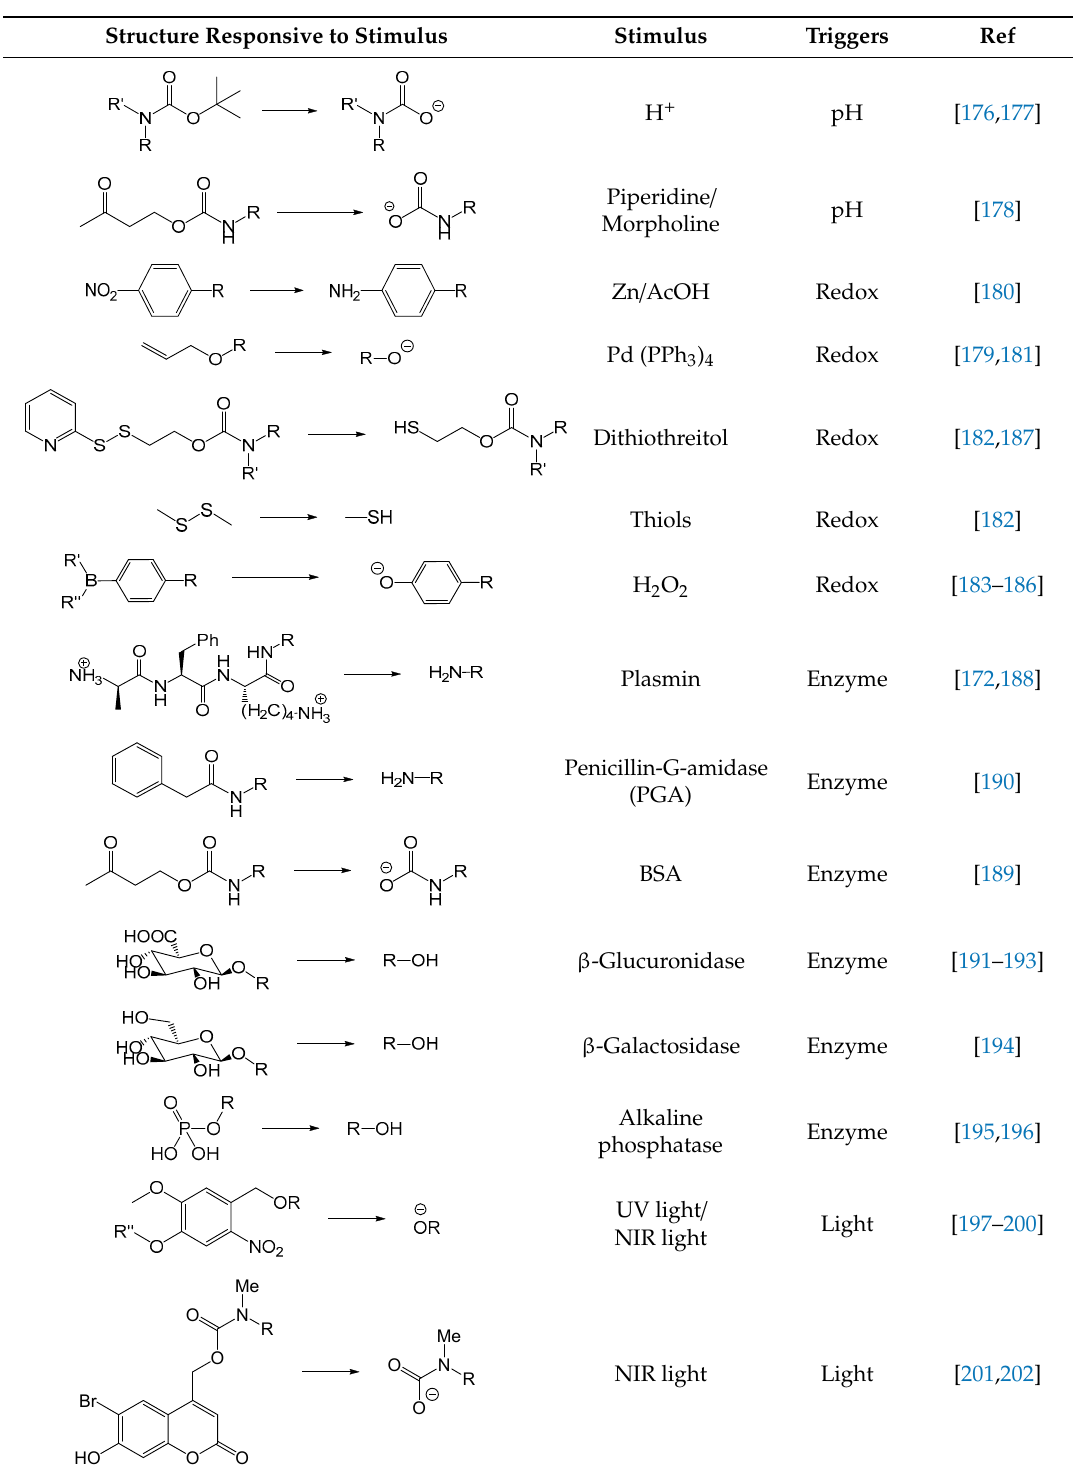
Table 4. Protection groups and stimuli of self-immolative linkers.